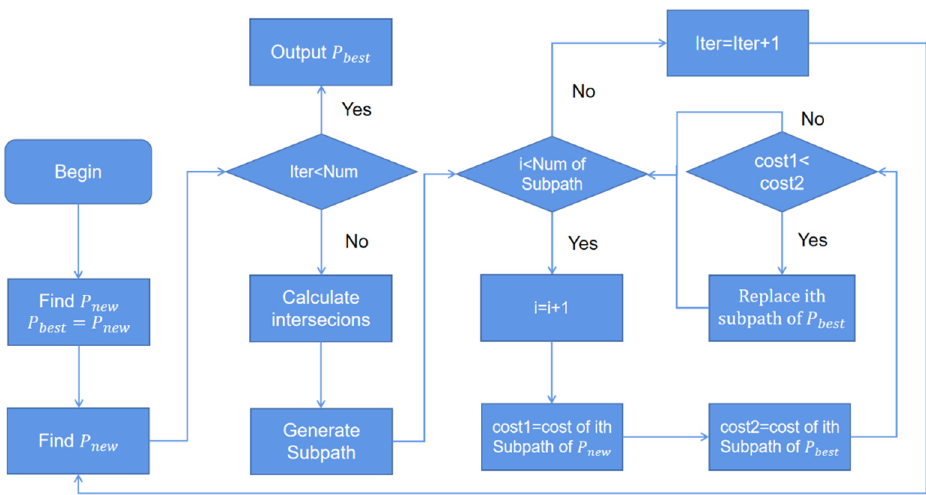
Figure 6. Schematic illustration of the algorithm flow chart of path fusion.